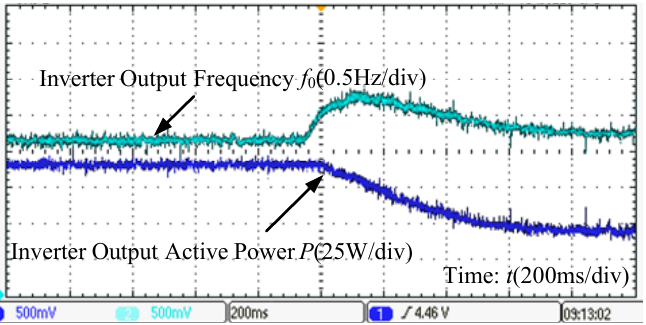
Figure 21. The output active power and frequency of the inverter when the damping coefficient D = 8.35 in a weak grid.